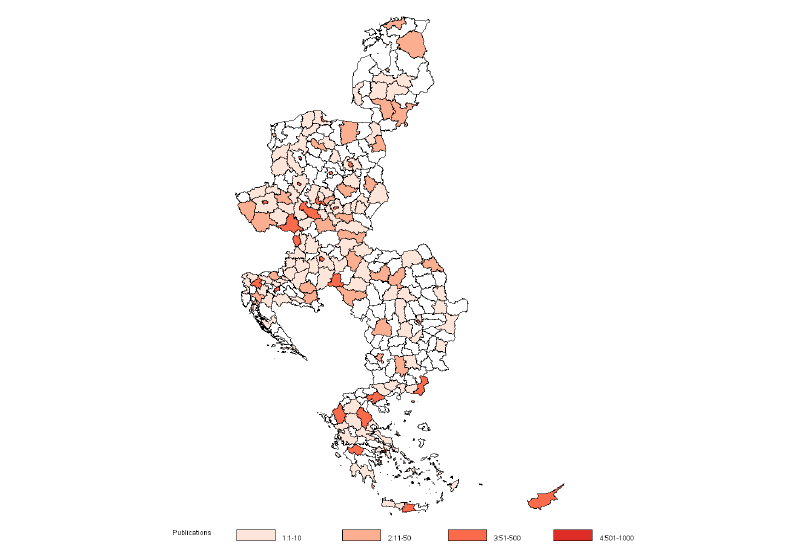
Figure A.2: Publication Output for Cardiovascluar Medical Devices at Regional levels of NUTS-3 in Europe: Bulgaria, Cyprus, Czech Republic, Estonia, Greece, Croatia, Hungary, Lithuania, Latvia, Romania, Slovakia, Slovenia